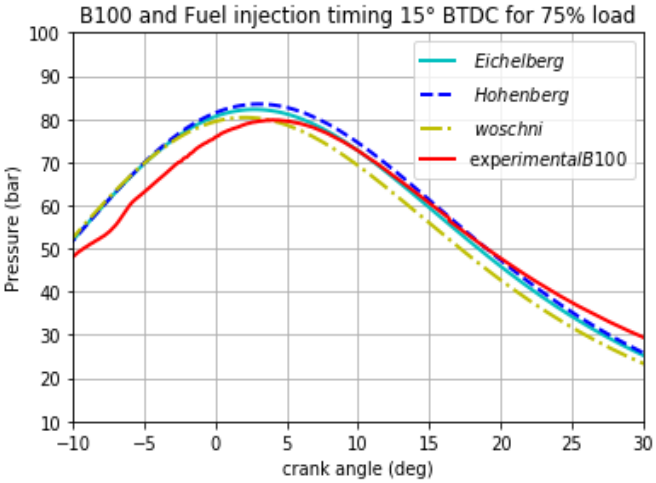
Figure 6. Cylinder pressure of B100 at 75% load.